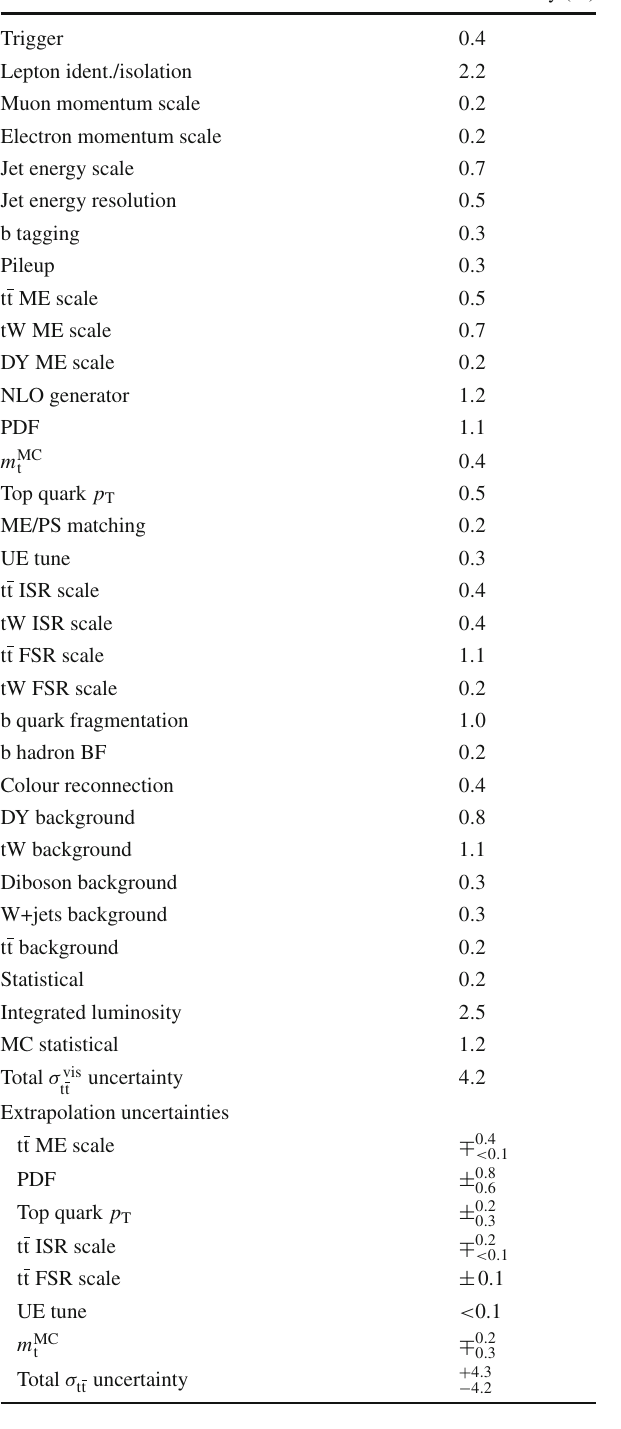
Table 3 The absolute uncertainties in m MC t and their sources, from the simultaneous fit of σ tt and m MC t . The MC statistical uncertainty is deter- mined separately. The individual uncertainties are given without their correlations, which are however accounted for in the total